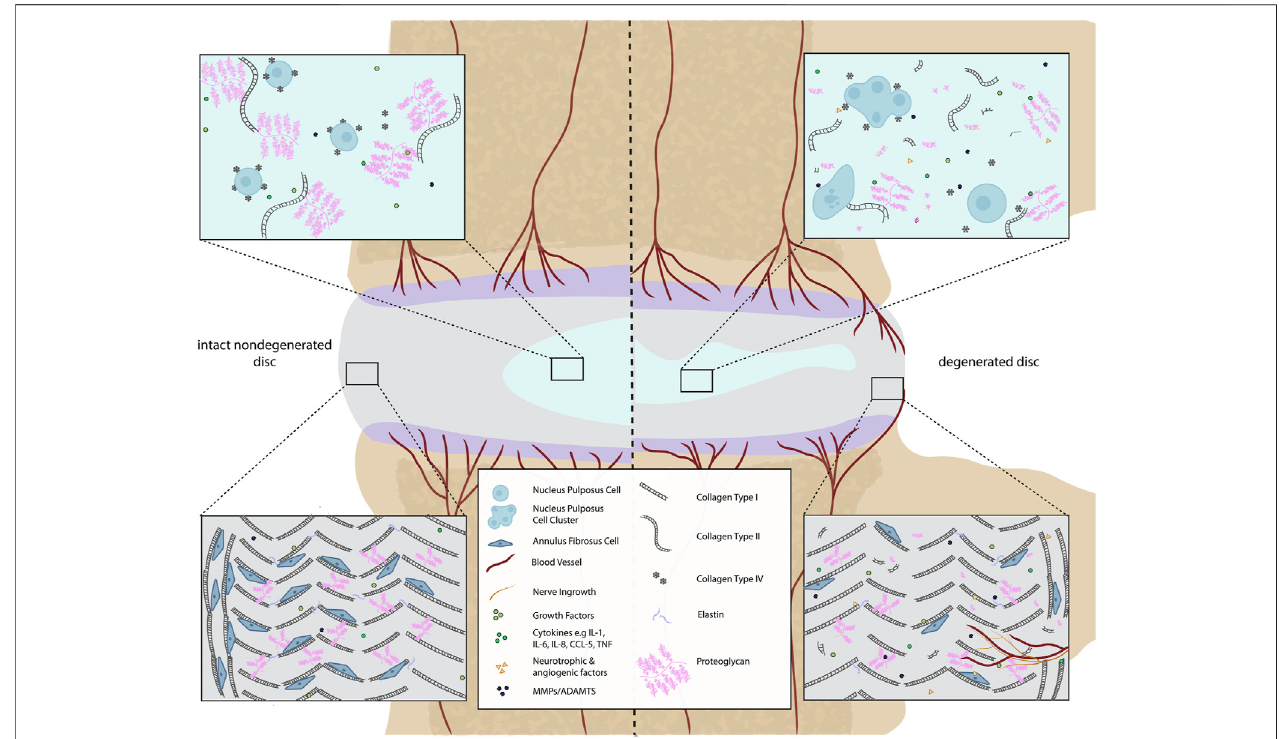
FIGURE 1 | Comparison of a healthy and a degenerated IVD disc (focused on ECM components). In the intact IVD, the NP matrix mostly contains proteoglycans (PG) and non-oriented collagen type II fi bers. The proteoglycans contain negatively charged sulfated groups leading to an intradiscal osmotic pressure crucial for the basal hydration of the NP and the biomechanical function of the IVD. Within the degenerated disc, the total content of PG decreases. Small non-aggregating PGs are present. This drop-in PG content negatively affects the swelling capacity of the disc. Additionally, during disc degeneration, the production of catabolic cytokines, matrix-degradingenzymes,andneurotrophicaswellasangiogenicfactorsoccurduetocellularchanges.ThiscanleadtobloodandnervevesselingrowthintheAF.The AF is composed of highly oriented concentric lamella of type I collagen whereas the cell density is higher in intact than in degenerated discs.